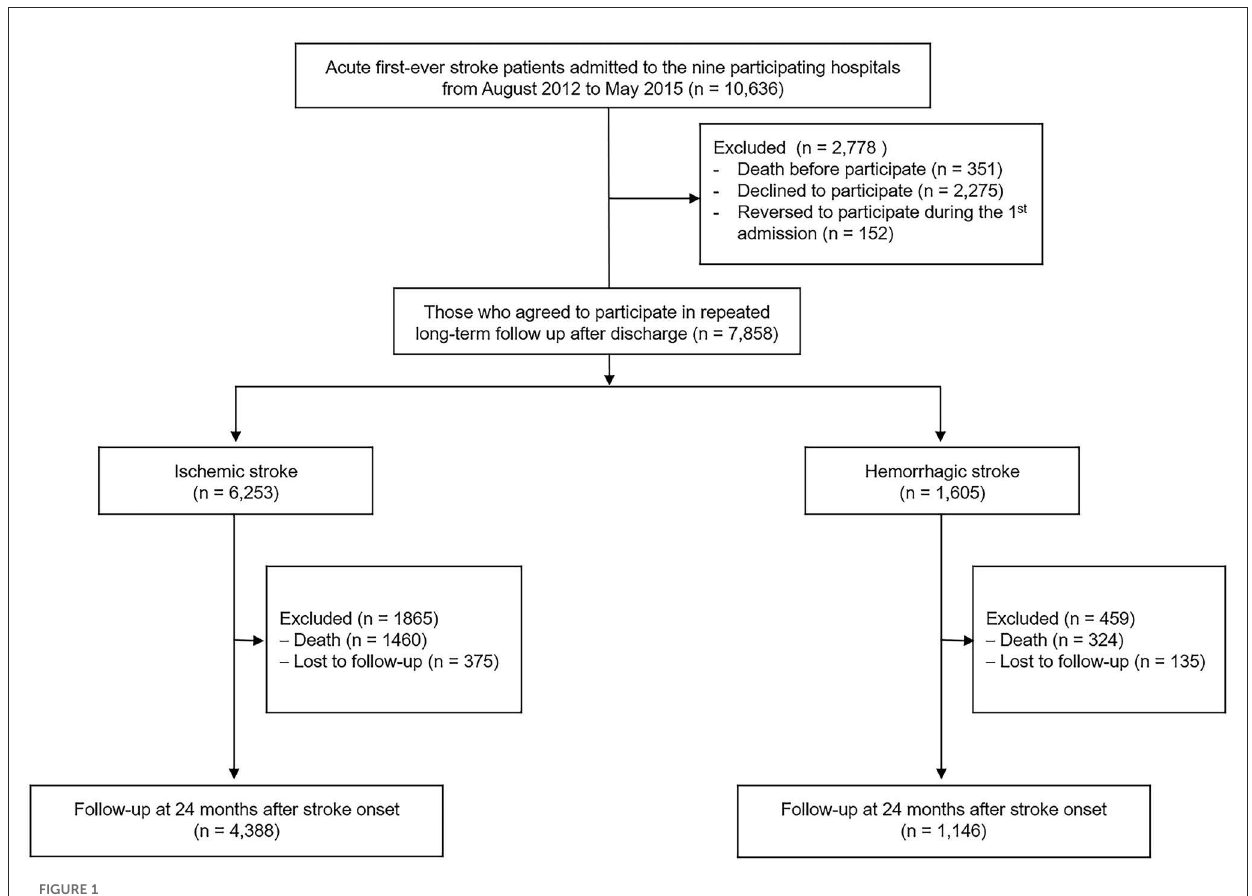
FIGURE1 Flow chart of participant